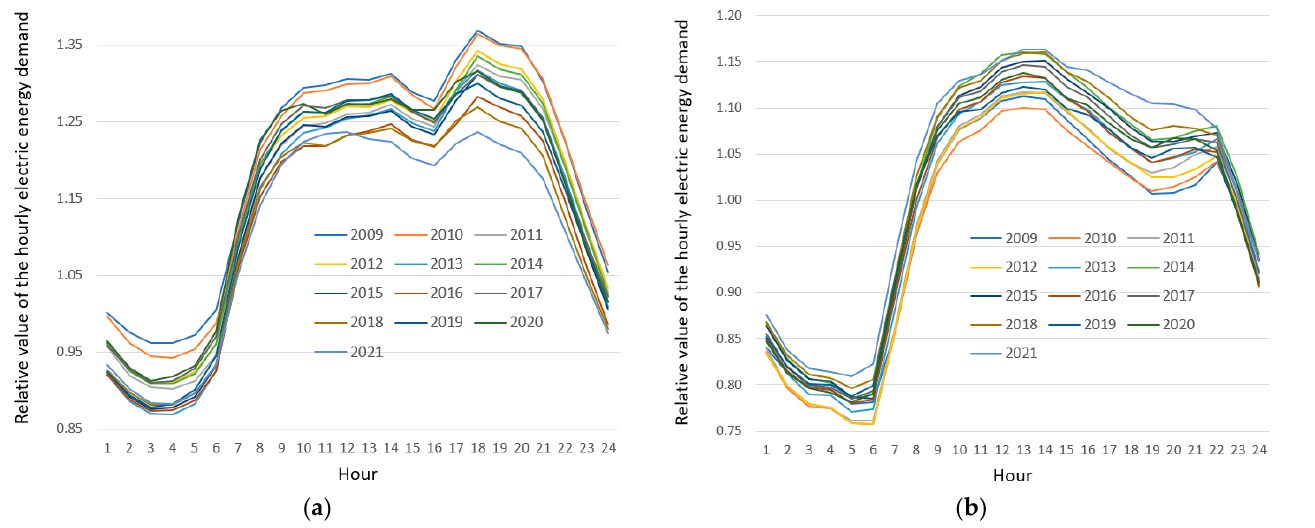
Figure 3. ( a ) Daily profiles of power demand for the winter typical day in Poland; ( b ) Daily profiles of power demand for the summer typical day in Poland.